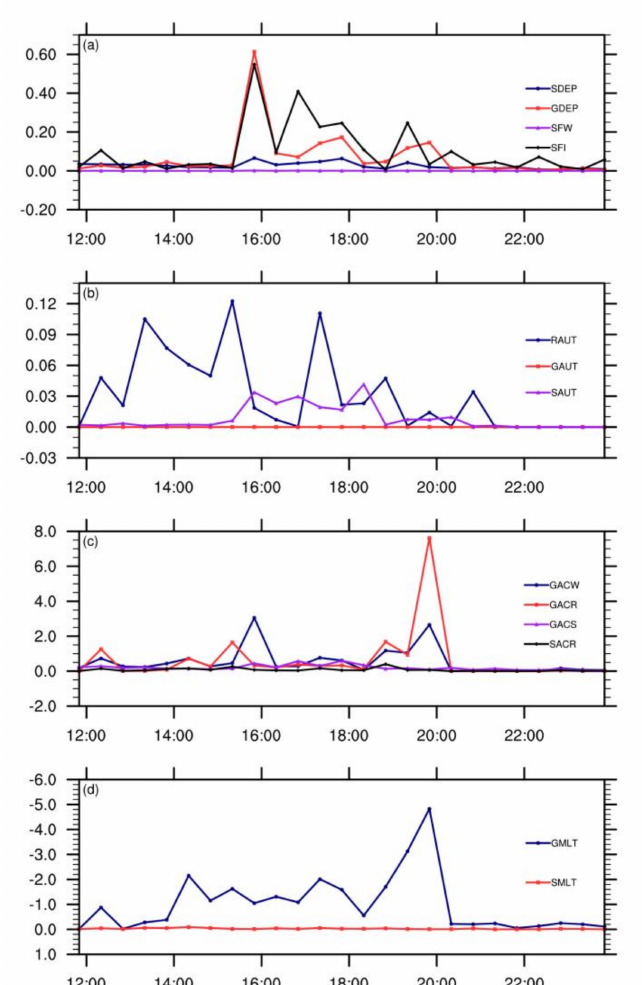
Figure 8. Microphysical process timing characteristics. ( a ) Sublimation and Bergeron, ( b ) ice phase particle aggregation, ( c ) coagulation, and ( d ) melt (unit: 10 − 5 g · kg − 1 · s − 1 ). This figure is obtained by regional averaging of the black dashed area (32.5–33.5 ◦ E, 96.5–97.5 ◦ N) in Figure